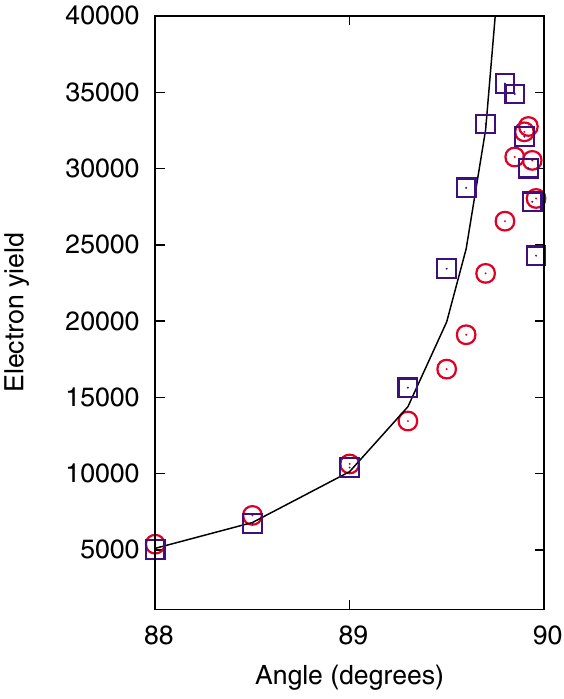
FIG. 4. (Color) The measured (red circles) and simulated (blue squares) electron yields as a function of angle of incidence of the ion measured from the surface normal for 182.0 MeV gold (cid:2) 18 (cid:3)A . The hitting stainless steel. The simulations used d esc simulation values are normalized to match Eq. (4) at 0 (cid:10) . The rms difference between simulated and measured yield is